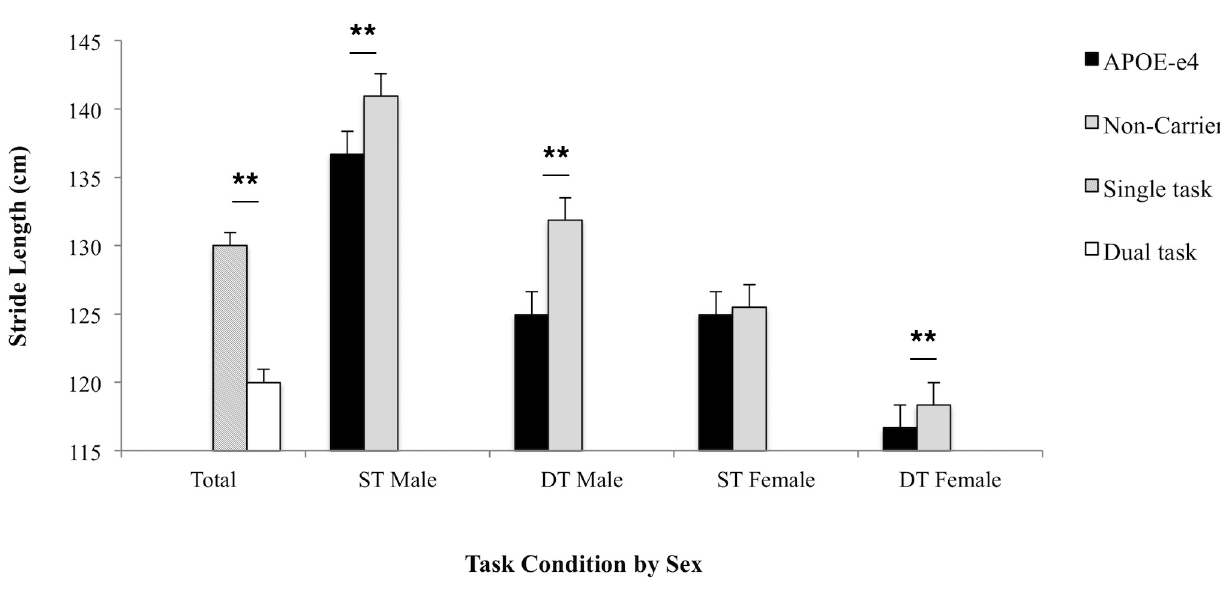
Fig 1. APOE-e4 carriers vs. Non-Carriers group means and standard errors for stride length (cm) by task condition and sex. Stride length was analyzed during single task (ST) and dual task (DT) conditions. Age, height, Short Physical Performance Battery, BMI and illness index scores were entered as covariates. Results represent the significant main effects of task condition and sex on stride length and the significant interaction between APOE-e4 genotype with task condition, * p < .05, ** p <